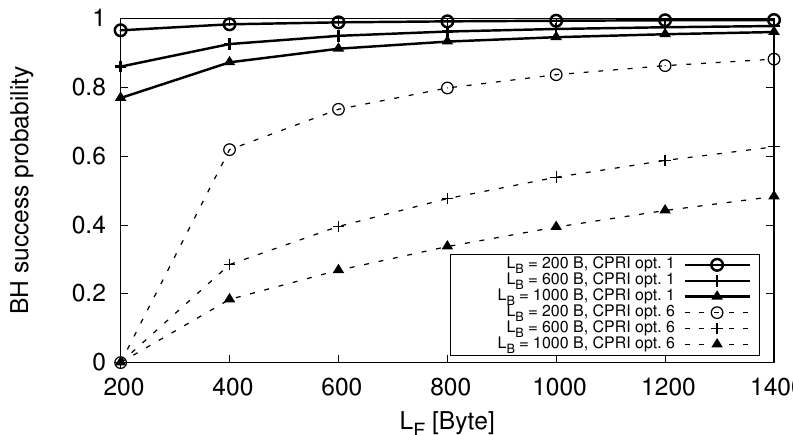
Figure 5. Backhaul (BH) success probability as a function of payload length L F for different BH packet length L B using CPRI opt. 1 and 6 without segmentation.